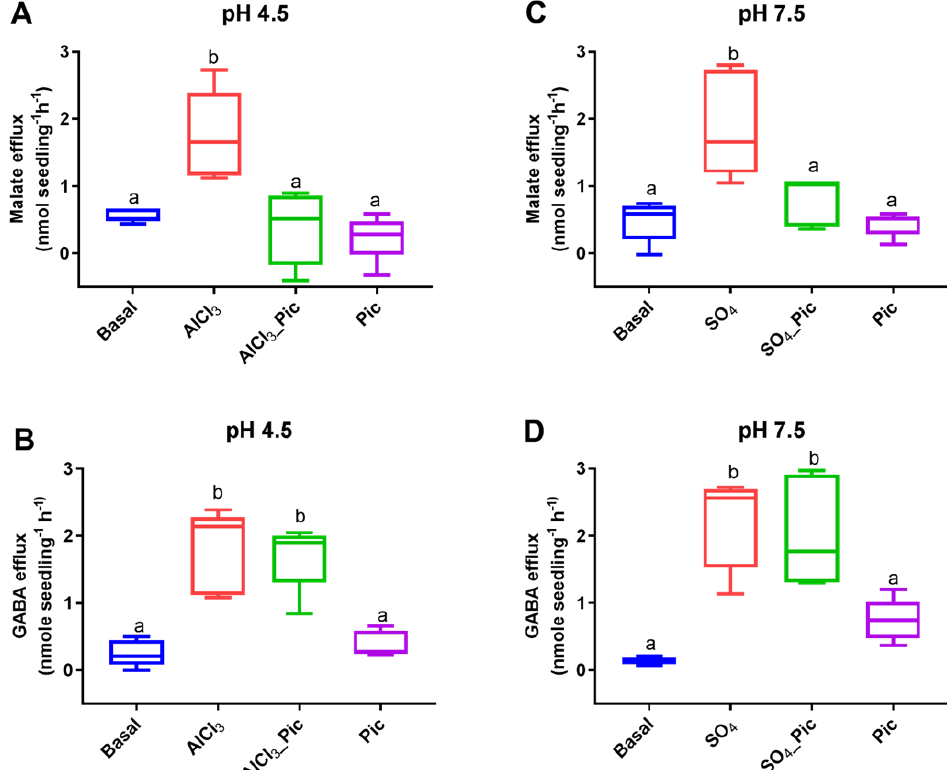
Figure 1. Inhibition of malate efflux but not GABA efflux from roots of Al-tolerant ET8 seedlings by picrotoxin. Aluminum (AlCl 3 ; 100 µ M) stimulated both malate and GABA efflux ( A , B ) at pH 4.5, but picrotoxin (Pic, 10 µ M) only inhibited malate efflux. A corresponding experiment with anion activation (10 mM SO 42 − ) of malate efflux at pH 7.5 ( C ) showed the same inhibition of malate efflux but not GABA efflux ( D ). Data shown ( n = 5) as box plots with letters representing significant differences based on one-way ANOVA. 3.2. Malate and GABA Efflux in Xenopus Laevis Oocytes Expressing ALMT Malate efflux was significantly higher in both the TaALMT1- and VvALMT9 -express- ing oocytes when they were exposed to Al 3+ (100 μM, pH 4.5) or Na 2 SO 4 (10 mM, pH 7.5), respectively (Figure 2A,C). Picrotoxin ( 10 μM) ± Al 3+ (100 μM) / Na 2 SO 4 (10 mM) did not inhibit GABA efflux from the oocytes (Figure 2B,D). The DMSO that was used to dissolve the picrotoxin had no effect on malate or GABA efflux (data not shown).